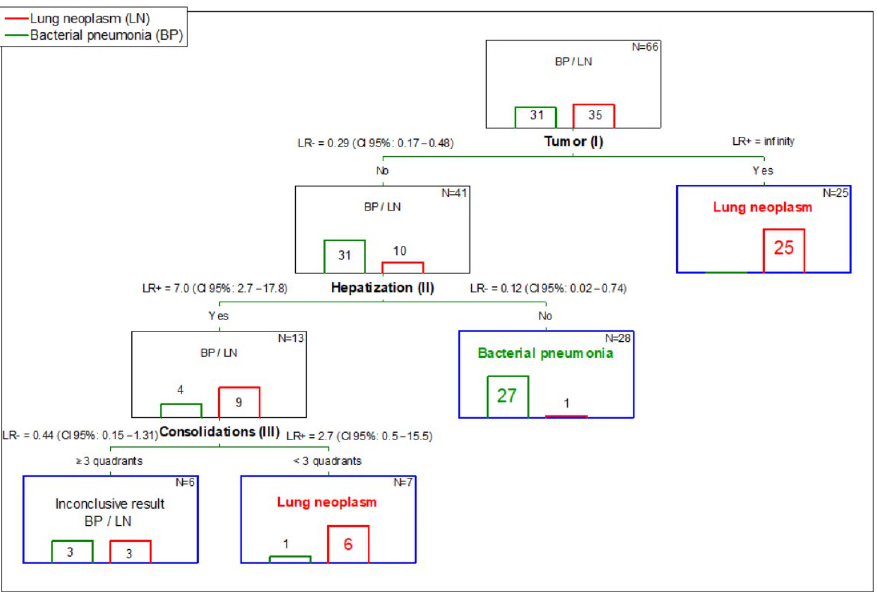
Figure 15. A Classification and Regression Tree (CART) for differentiation between lung neoplasm (LN) and bacterial pneumonia (BP) in dyspneic dogs without heart disease based on three lung ultrasound (LUS) abnormalities—tumor, hepatization, and subpleural consolidations. LR+ and LR- stand for positive and negative likelihood ratio, respectively. CI 95% is a 95% confidence